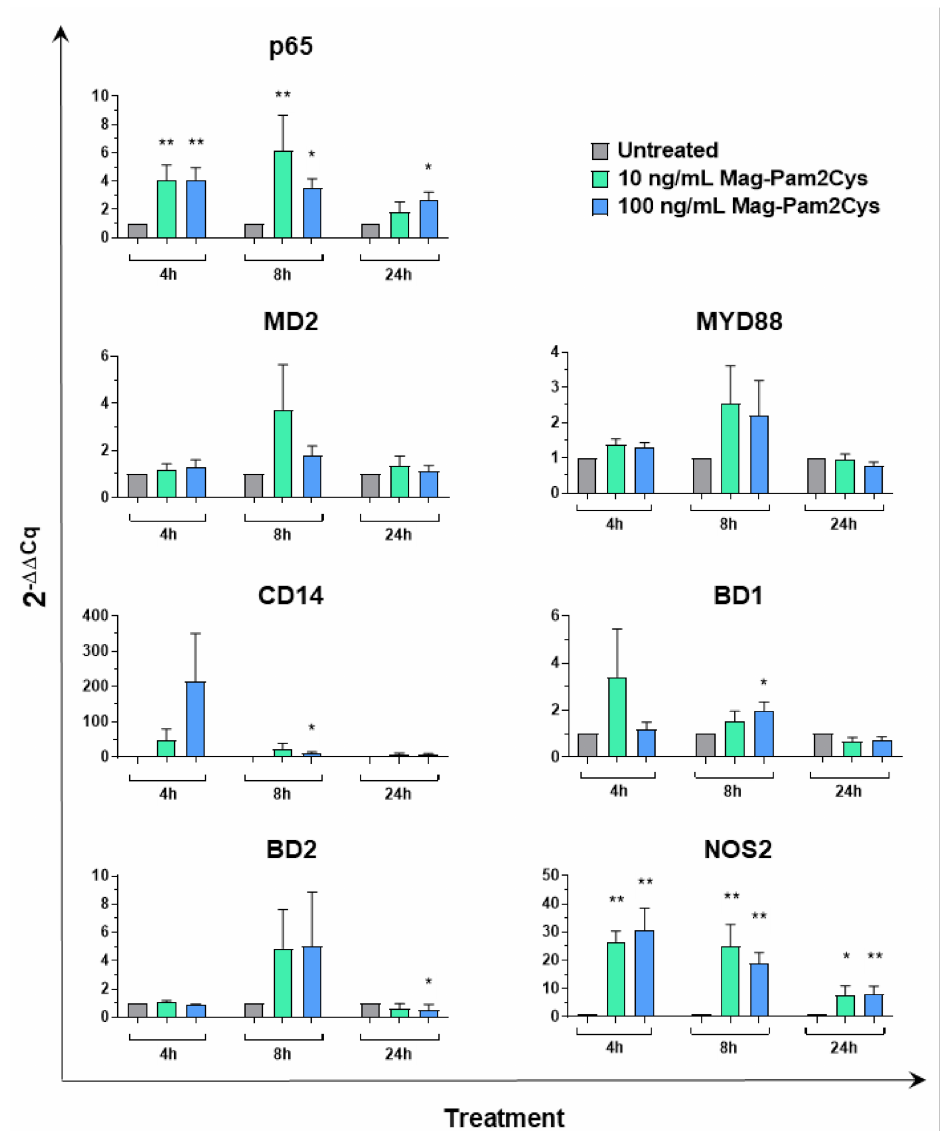
Figure 9. Gene expression of seven key genes of the innate immunity following stimulation with Mag-Pam2Cys. MoM Φ were left untreated or stimulated with scalar doses of Mag-Pam2Cys (10 or 100 ng/mL). At 4, 8, and 24 h post-stimulation, gene expression levels of p65, MYD88, MD2, CD14, BD1, BD2, NOS2 were determined using qPCR. At each time point, data were normalized on the values of untreated control and expressed as 2 − ∆∆ Cq , with ∆ Cq = Cq (target gene)—Cq (reference gene), and ∆∆ Cq = ∆ Cq (Mag-Pam2Cys-stimulated samples)— ∆ Cq (untreated sample, moM Φ ). Mean data and SD from six independent experiments using different blood donor pigs are shown. For each time point, values of Mag-Pam2Cys-stimulated samples were compared to the corresponding untreated control (moM Φ ) using a Kruskal–Wallis multiple comparison test. ** p < 0.01, * p <